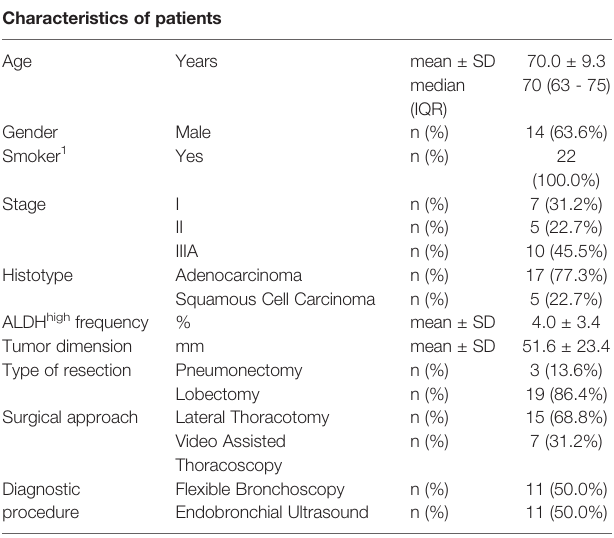
TABLE 2 | Characteristics of